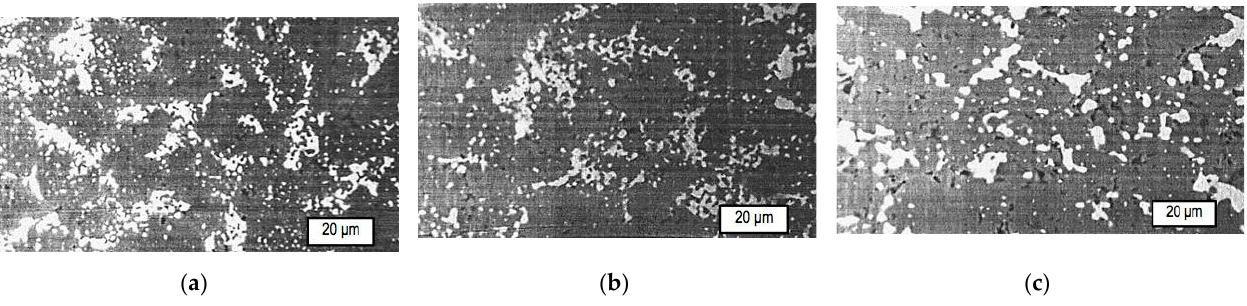
Figure 9. Microstructure of Сr 2 O 3 + (Cr,Al) 2 O 3 + 22 wt.% Cr cermet samples sintered from Cr 2 O 3 + 13 wt.% Al powder at Т = 1500 °С under Р = 30 MPA for different lengths of time t : ( a ) 5 min; ( b ) 10 min; ( c ) 15 min.